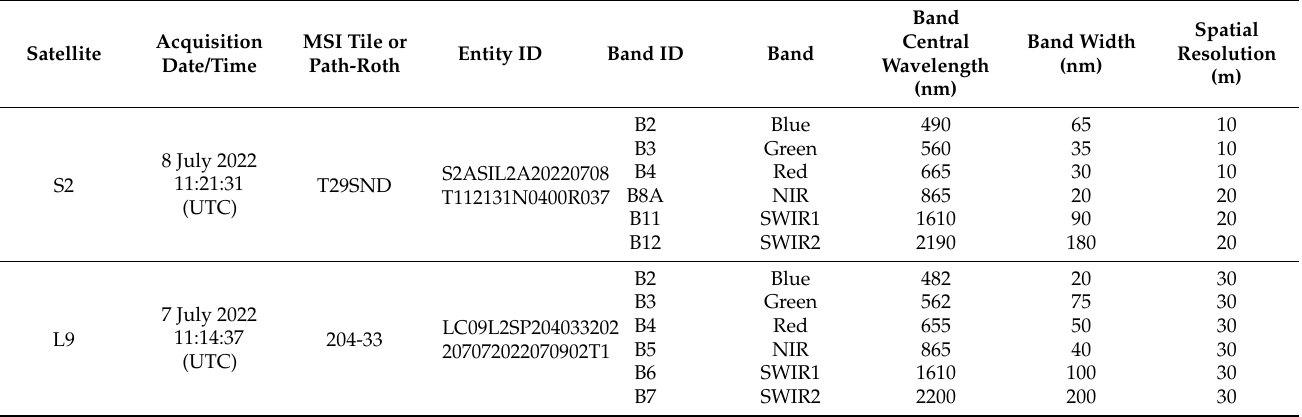
Table 1. Attributes of the Sentinel-2 (S2) and Landsat 9 (L9) satellite imagery used in this study. NIR stands for near infrared and SWIR for shortwave infrared.